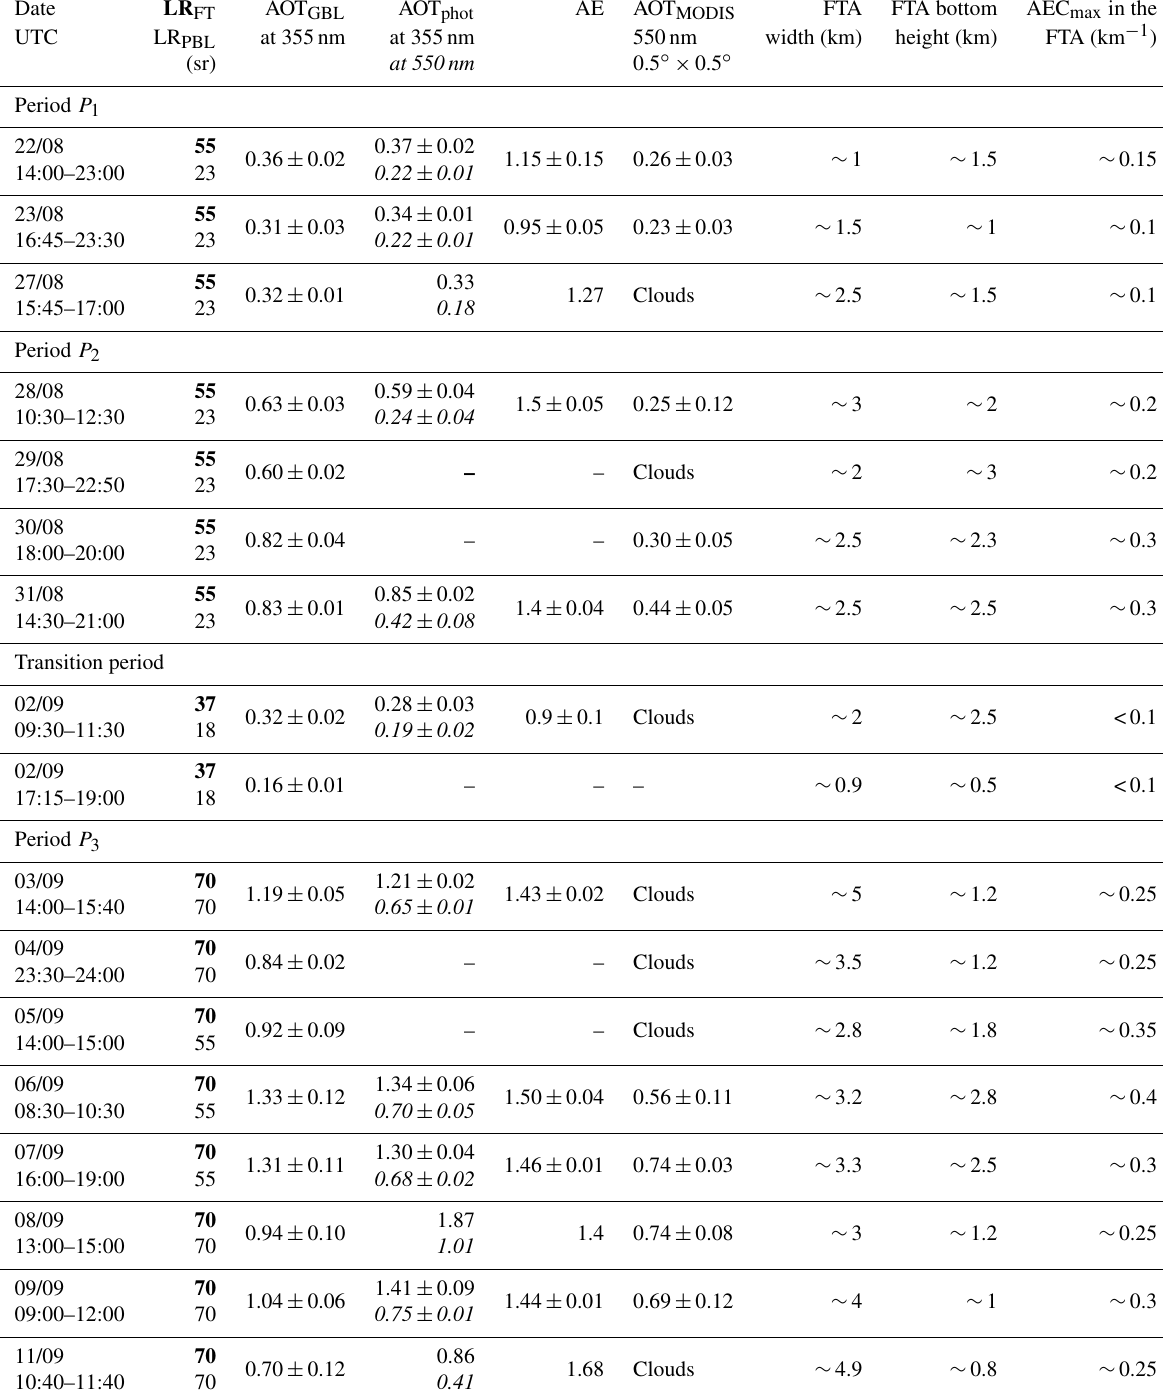
Table 3. Properties of aerosol layers above the Henties Bay site as derived from the ground-based lidar, CALIOP, CATS, the Sun photometer and MODIS: lidar ratios selected for the free troposphere (LR FT ; in bold) and the planetary boundary layer LR PBL at 355nm, ground-based lidar (GBL)-derived AOT GBL at 355nm and its uncertainty (detection noise and atmospheric variability), Sun-photometer-derived AOT phot at 355 and 550nm, Sun-photometer-derived Ångström exponent (AE), MODIS-derived AOT MODIS in 0.5 ◦ × 0.5 ◦ area over the sea close to Henties Bay, free troposphere aerosol (FTA) layer thickness and bottom height and maximum of the aerosol extinction coefficient (AEC max ) in the FTA. P 1 and P 2 correspond to periods when the AFT is mostly composed of “polluted dust”, and P 3 corresponds to the period when smoke aerosols dominate the composition of the